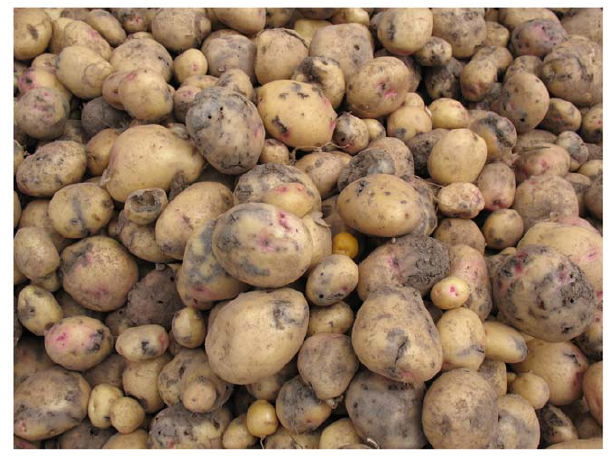
Figure 1. Heavy infestations by Andean potato weevils ( Premnotrypes spp.) on improved potato cultivar Yungay ( S. tuberosum ). Photo credit: Soroush Parsa.